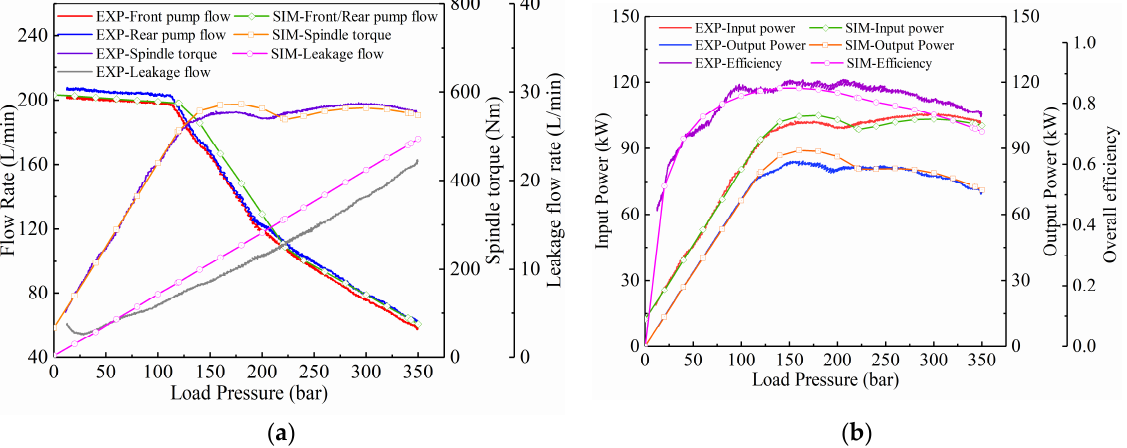
Figure 13. Characteristics curves of the double-compound axial piston pump under working condi- tion 2: ( a ) outlet flow, spindle torque, and leakage flow; ( b ) input power, output power, and overall efficiency.